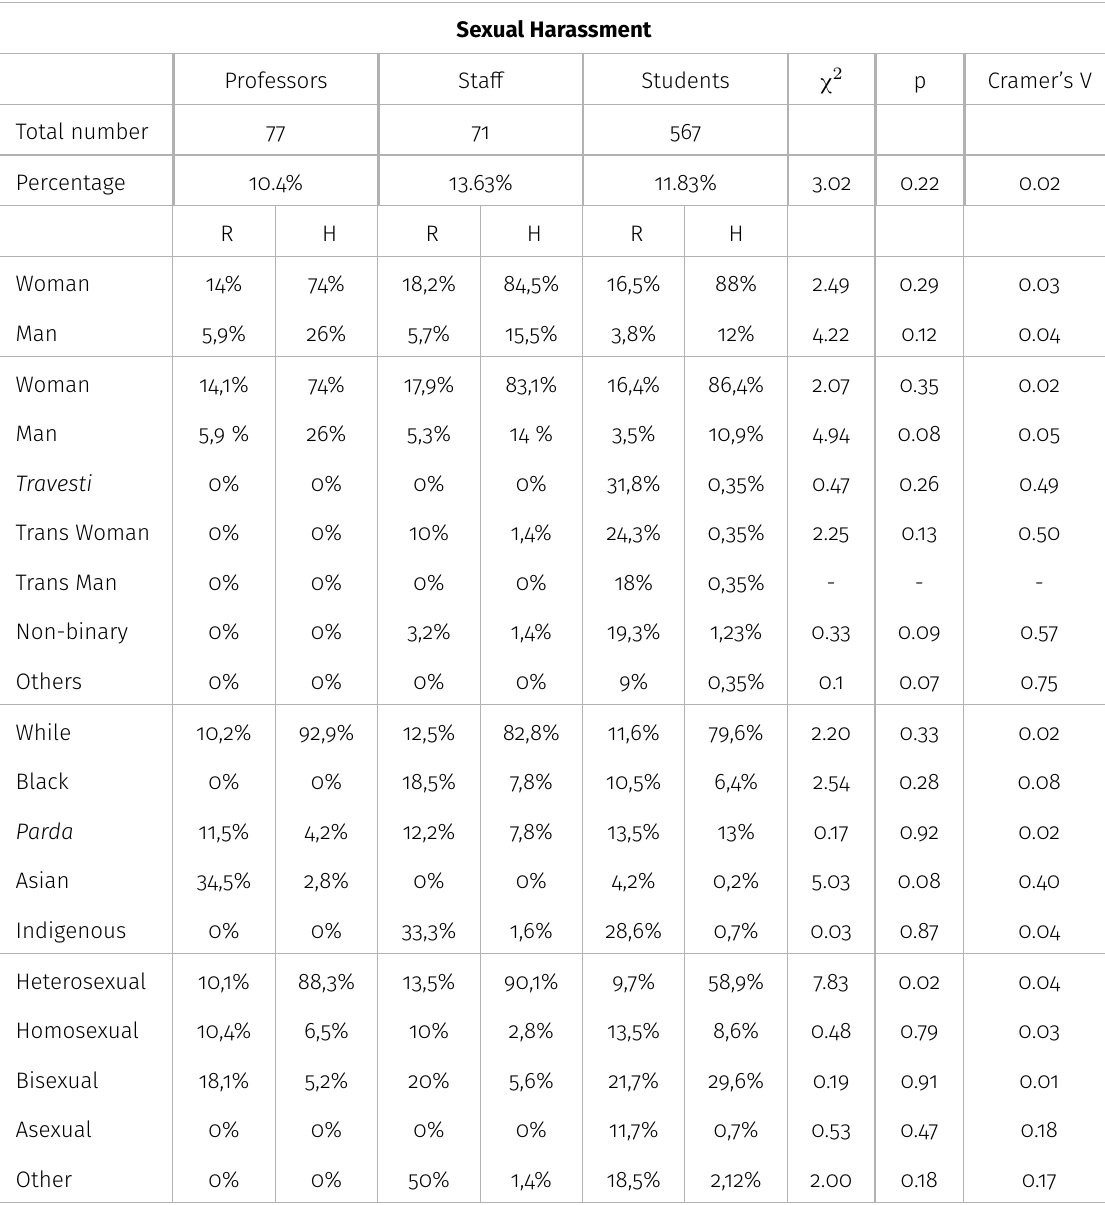
Table III. The structure is the same as in Table II, but here is for Sexual harassment. Sexual